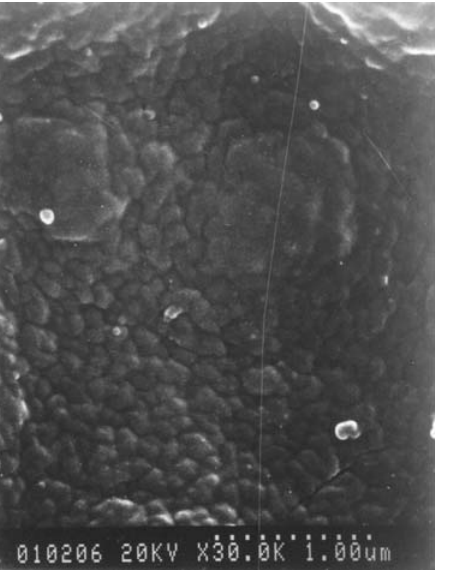
Figure 4. The SEM pictures of (a) Pt/poly(3-TPAA) and (b)